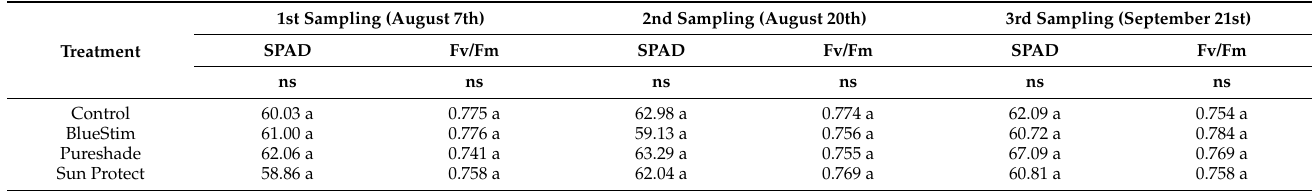
Table 4. Effects of alleviating products on kiwifruit leaf chlorophyll (SPAD) and fluorescence (Fv/Fm) (first–third sampling events).